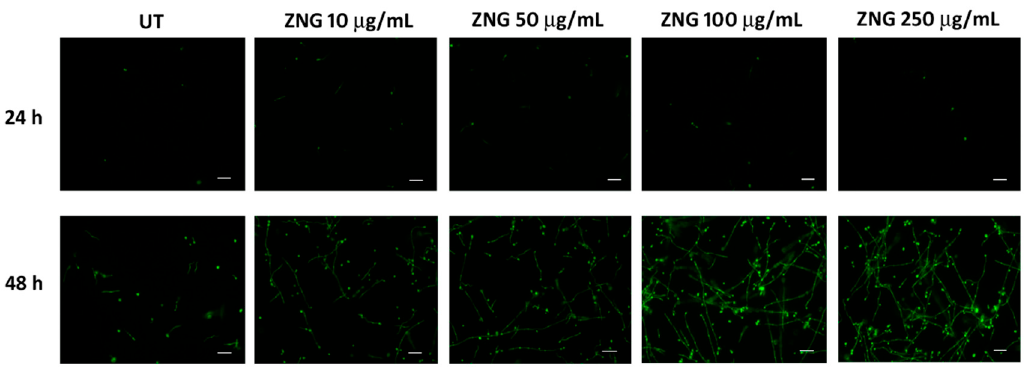
Figure 5. Fungicidal activity of ZNGs nanomaterials on C. albicans biofilm. The biofilm formation, at the indicated concentrations of ZNGs, was obtained in 12-well cell culture plates at 37 °C for 24 h or 48 h. Afterward, the cells were stained with SYTOX Green and visualized at 32 × magnification. Untreated biofilm (UT) was used as negative control. Scale bar 20 µ